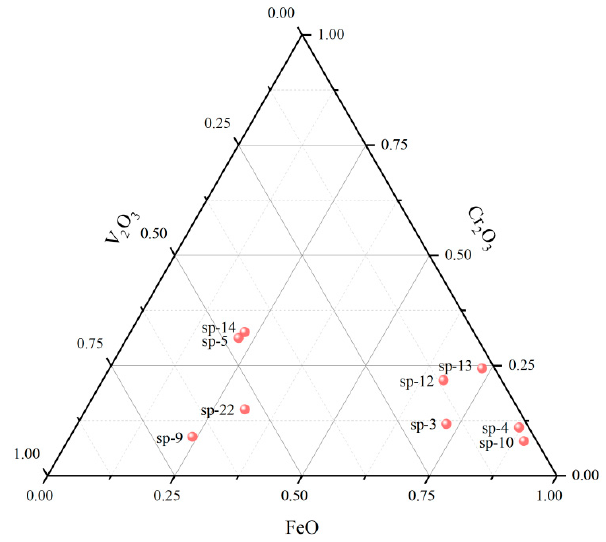
Figure 5. Spinel Cr 2 O 3 -V 2 O 3 -FeO (wt%) ternary phase diagram.